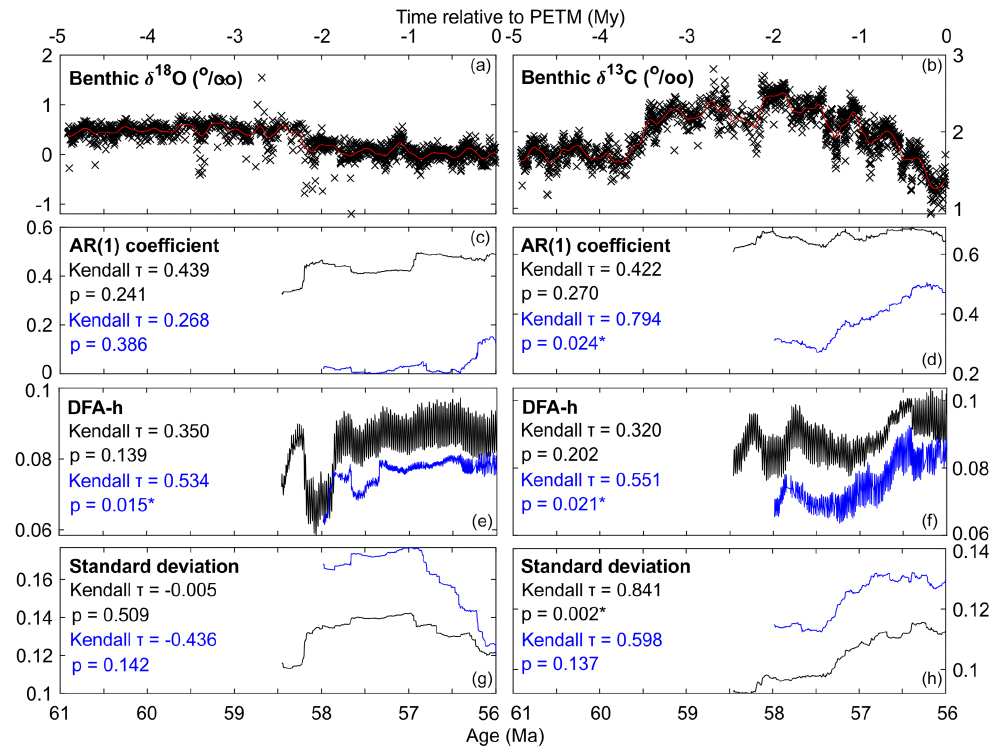
Figure 2. Rolling window resilience analysis of benthic δ 18 O (a) , (c) , (e) , (g) and δ 13 C (b) , (d) , (f) , (h) in the run-up to the PETM. Panels (a) and (b) illustrate the palaeorecord (black crosses) and the detrending applied to the data (red line), with the panels below illustrating the results of the analysis for (c, d) AR(1) coefficient, (e, f) detrended fluctuation analysis h value, and (g, h) standard deviation calculated in a 50% rolling window across each time series for both interpolated (black line) and non-interpolated (blue line) data with the Kendall τ rank correlation and bootstrapped p value for each. Results for skewness, kurtosis, and sensitivity analyses for all metrics can be found in the